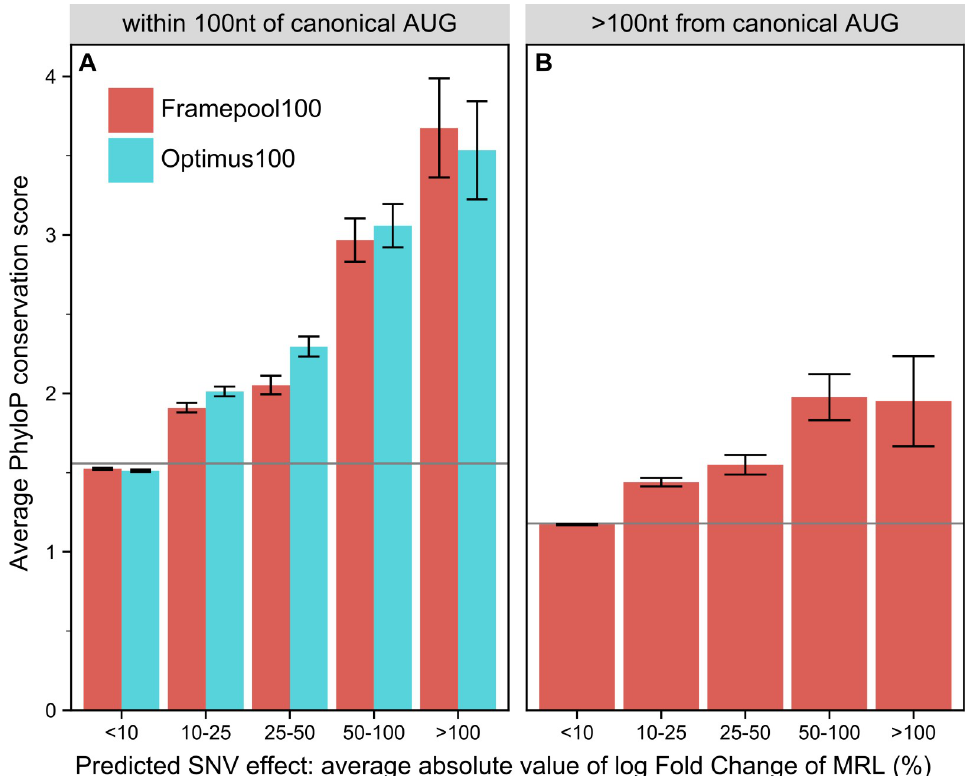
Fig 5. Comparing the predicted impact of every possible 5’UTR SNV with conservation scores for loss-of-function intolerant genes. A) For positions no further than 100 nt from the canonical transcript start codon, both Optimus100 and FramePool100 can predict the impact of SNV. Positions where a SNV is predicted to have a high impact on average also tend to be more strongly conserved. Error bars correspond to 95% confidence intervals. The grey line shows the average PhyloP score among all analysed 5’UTR position. B) For 5’UTR positions further than 100 nt from the canonical start, only FramePool100 can be applied. Again, positions where the SNV impact is predicted to be higher also tend to be more highly conserved. This further demonstrates that FramePool100 can identify biologically relevant regulatory elements even in sequences longer than those it has been trained on.